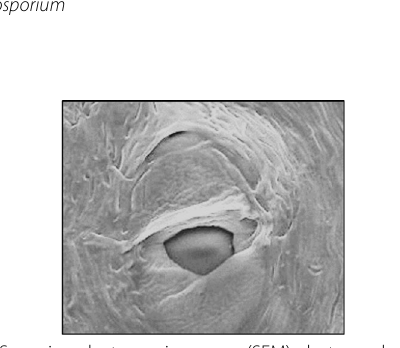
Fig. 2 A Scanning electron microscope (SEM) photographs of the perennial pattern present on the swollen female of M.